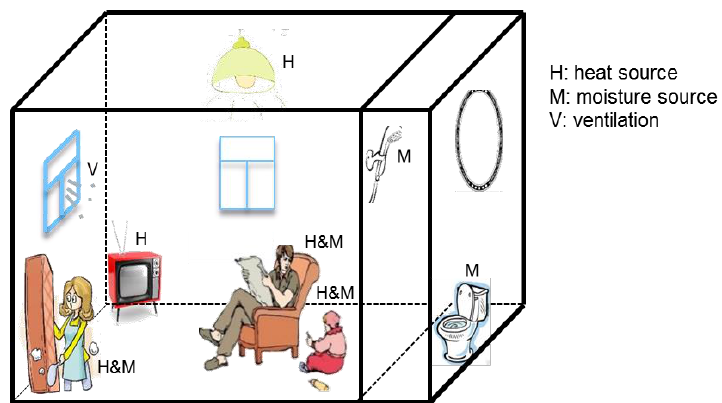
Figure 2. The sketch map of an ordinary home occupied with parents and one child.